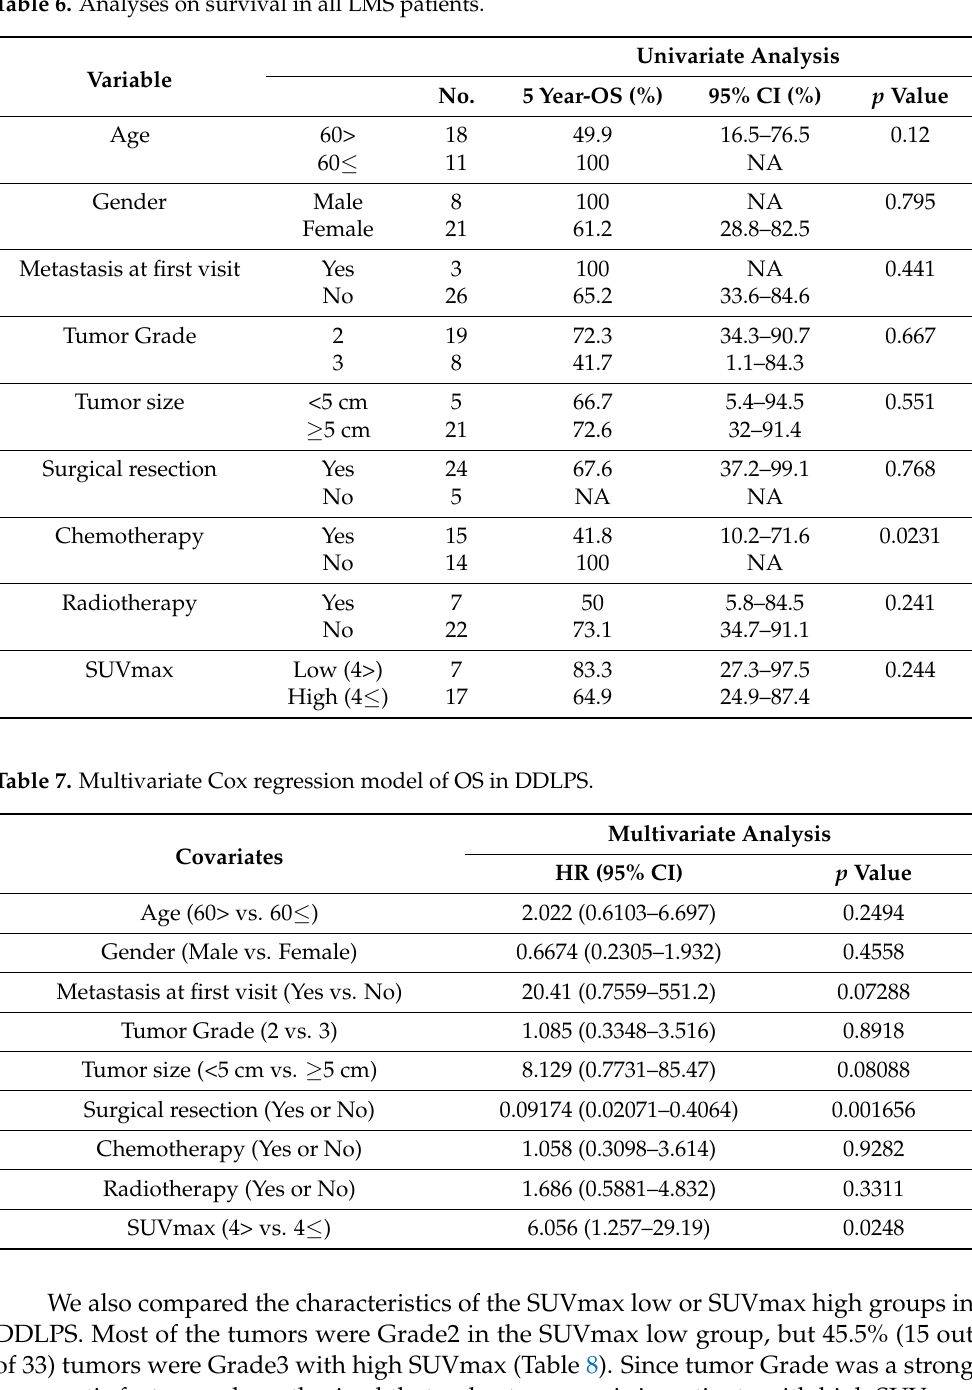
Table 6. Analyses on survival in all LMS patients.